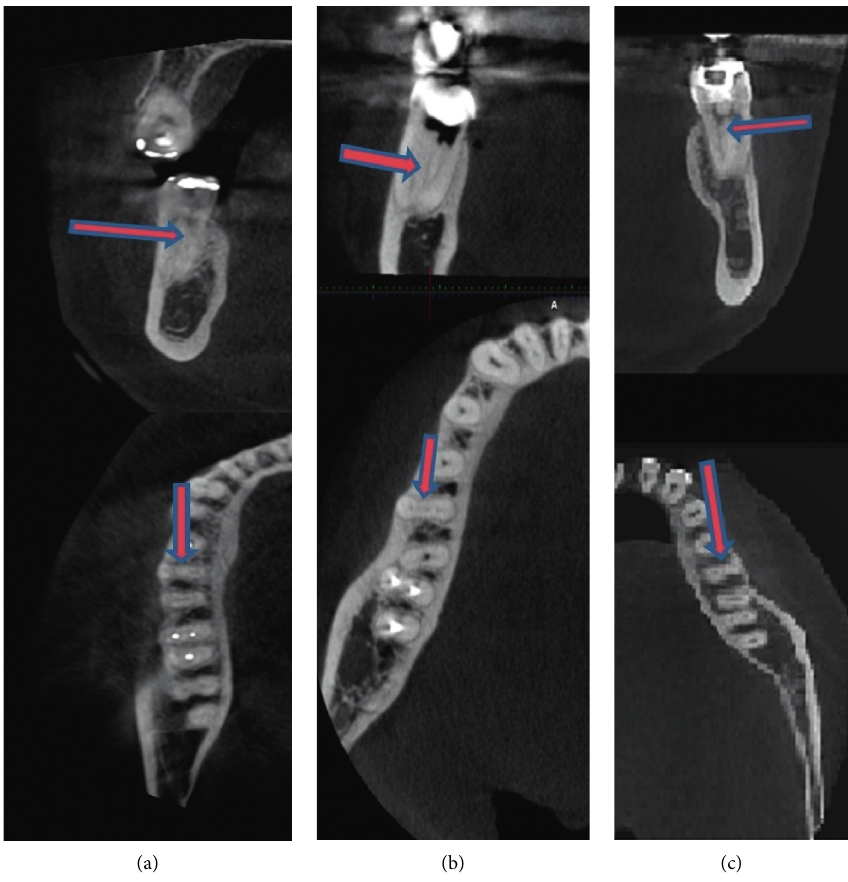
Figure 3: Cases 3 to 5 of mid mesial canals. (a) 42-year-old female. (b) 30-year-old male. (c) 28-year-old